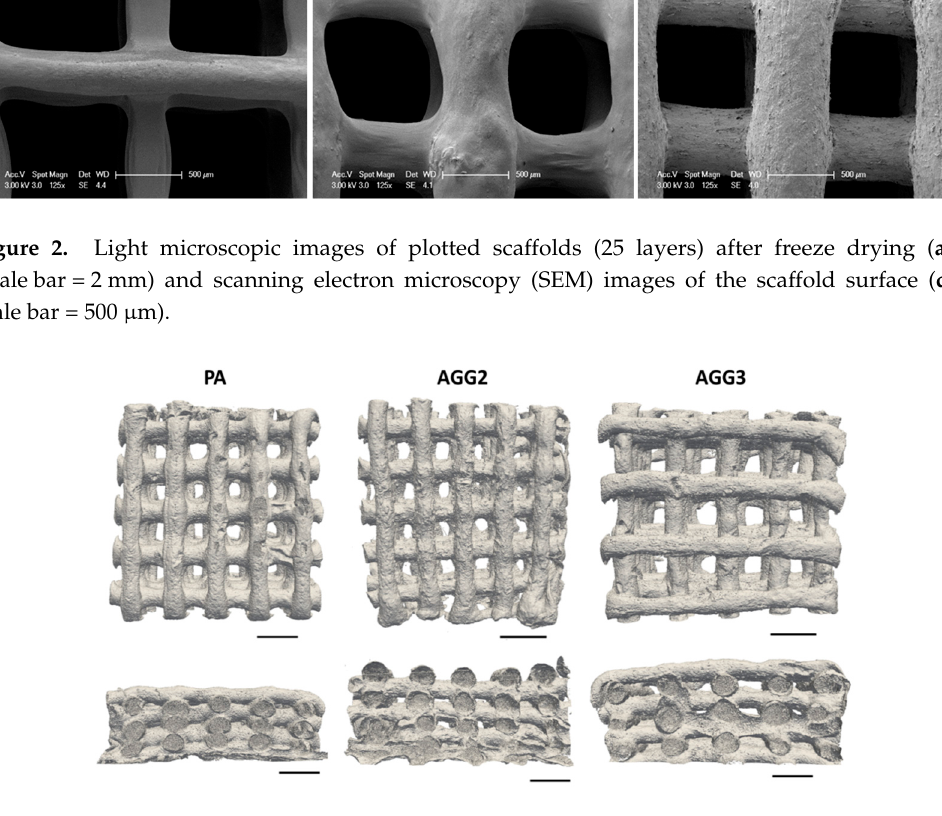
Figure 3. Reconstructed micro-computed tomography ( µ -CT) images of the plotted scaffolds in